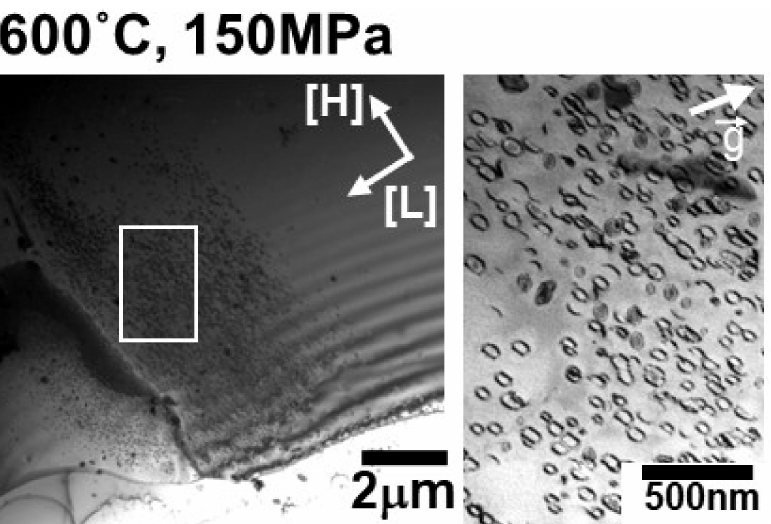
Figure 5. TEM micrographs of thermal-creep-deformed V–4Cr–4Ti alloy at 600 ◦ C and 150 MPa for 2800 h. The left side of the low-magnification image shows that precipitates gathered along a grain boundary and the right side of the high magnification image shows that precipitates on {100} habit plane were formed. [L] and [H] indicate the direction of the longitudinal direction and horizontal direction of the creep tube, respectively. (after Fukumoto et al.